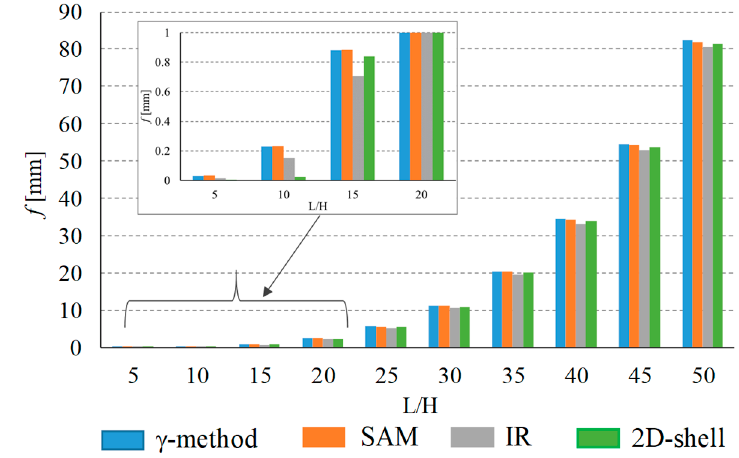
Buildings 2020 , 10 , 42 Figure 7. Values of instantaneous deflections. Figure 7. Values of instantaneous deflections.